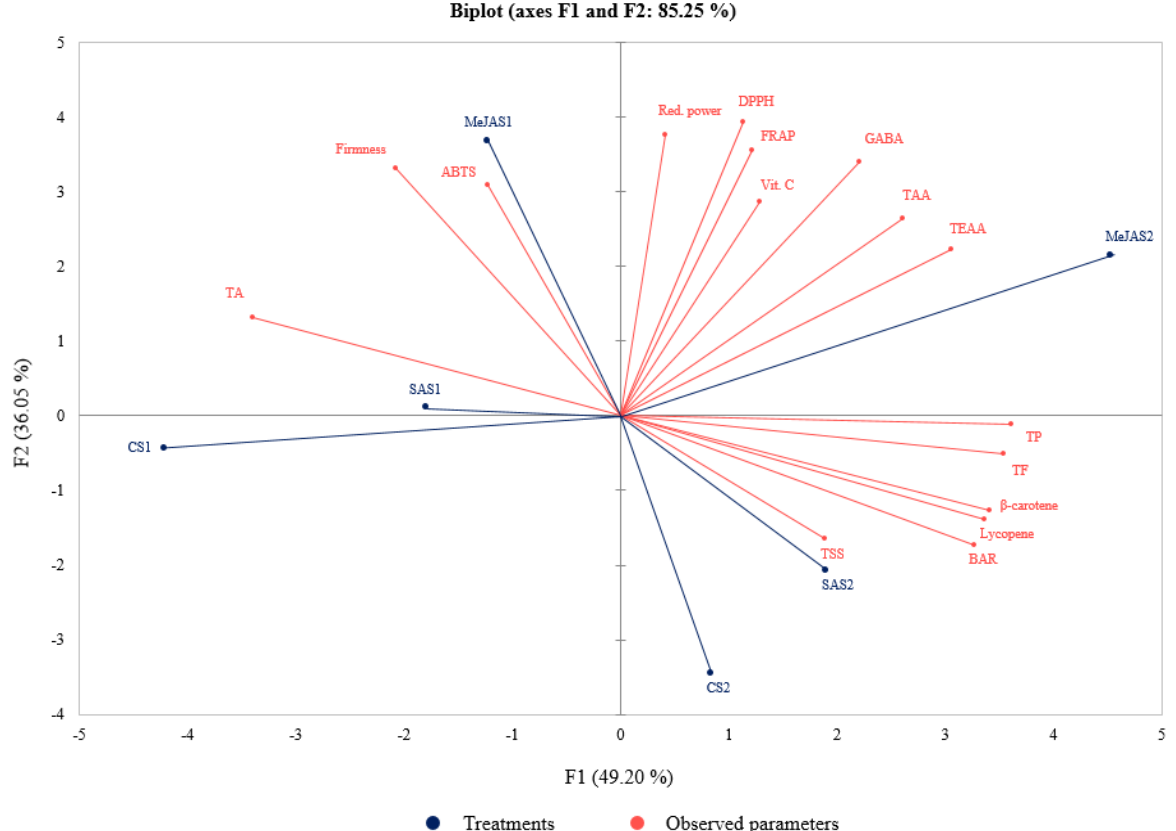
Figure 3. Biplot of the principal component analysis of the observed parameters of ‘Kumato’ tomato cultivar in the control and treatment (0.25 mM MeJA and 0.5 mM SA) groups at two maturity stages. CS1, CS2, MeJAS1, MeJAS2, SAS1, and SAS2 represent control, preharvest MeJA and SA treatments at S1 and S2 maturity stages, respectively. TSS, TA, BAR, TP, TF, TAA, TEAA, GABA, Vit. C, DPPH, ABTS, FRAP and Red. power represent total soluble solids, titratable Acidity, Brix acid ratio, total phenolics, total flavonoids, total amino acids, total essential amino acids, γ -aminobutyric acid, vitamin C, 2, 2-di-phenyl-1-picrylhydrazyl radical scavenging capacity, Trolox-equivalent antioxidant capacity, and ferric-reducing antioxidant power, and reducing power, respectively.